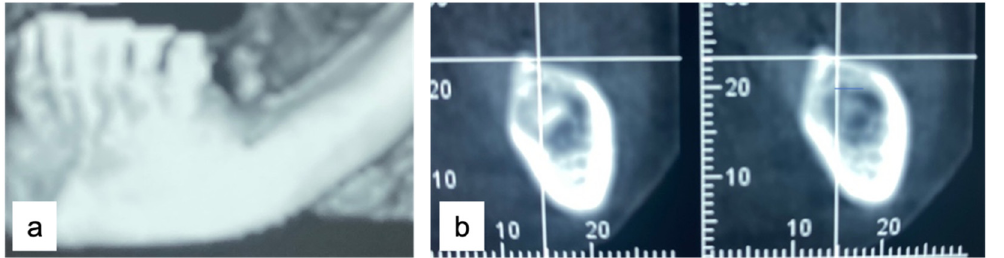
Figure 3. CBCT at baseline: ( a ) volumetric reconstruction of the edentulous area; ( b ) cross-section of the area. Table 1. Checklist of the therapeutic interventions followed during case management. The